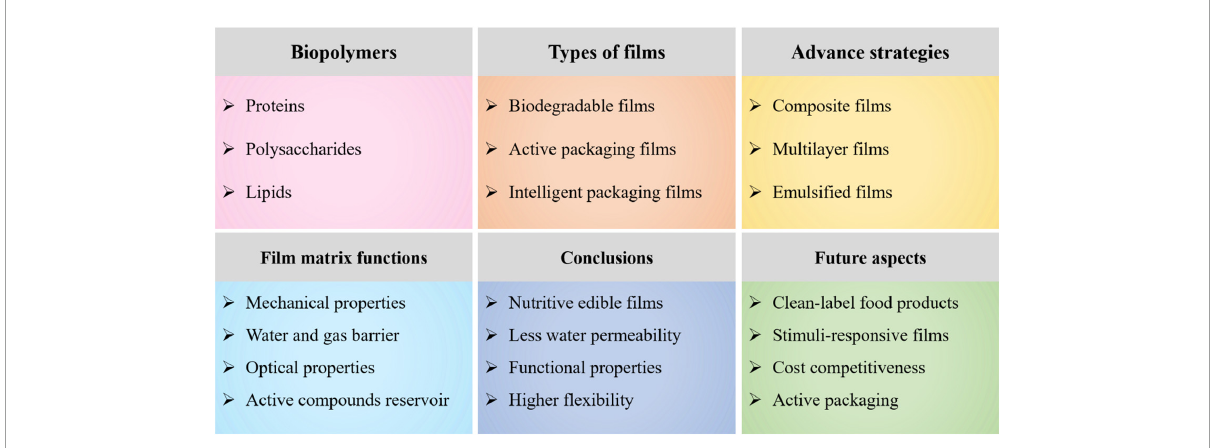
FIGURE1 An overview diagram elaborating biopolymer-based films, their classification, advance strategies to fulfill functionality of films, special functions induced by biopolymers to the films matrix, conclusions, and future